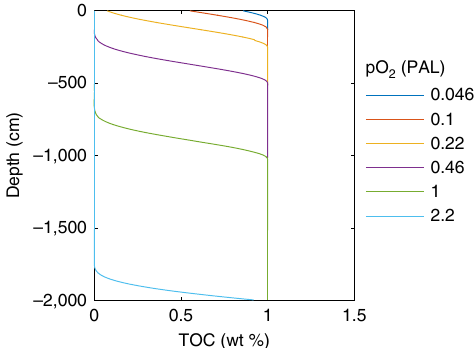
Figure 6 | Dependence of the organic carbon oxidative weathering horizon depth on pO 2 . Results of the shale model assuming default model parameters (see ‘Methods’ section, Table 2) with initial TOC content of 1wt%, pyrite S content 0.8 wt% (pyrite not shown), erosion rate of 5cmkyr (cid:2) 1 , and values of atmospheric pO 2 (PAL) as shown in the legend. The lines show the TOC remaining as a function of depth for different prescribed pO 2 (PAL) levels. In each case a distinct weathering horizon forms (above which TOC has been oxidized and below which it has not), with the weathering horizon at greater depth for higher pO 2 .